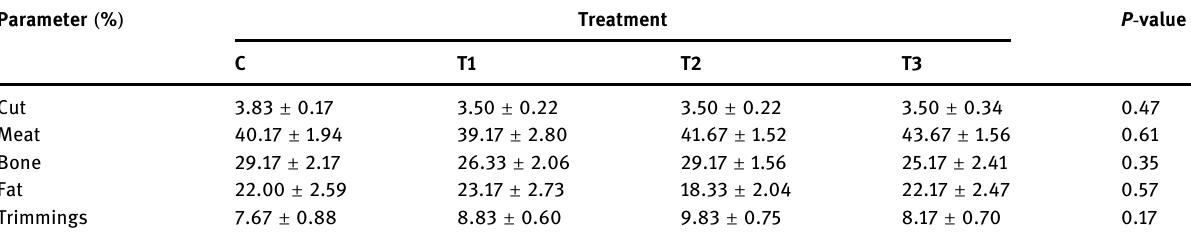
Table 12: Carcass composition ( % ) of DFM - o ff ered growing Najdi lambs weaned at di ff erent ages ( mean value ± SE ) Parameter ( % )